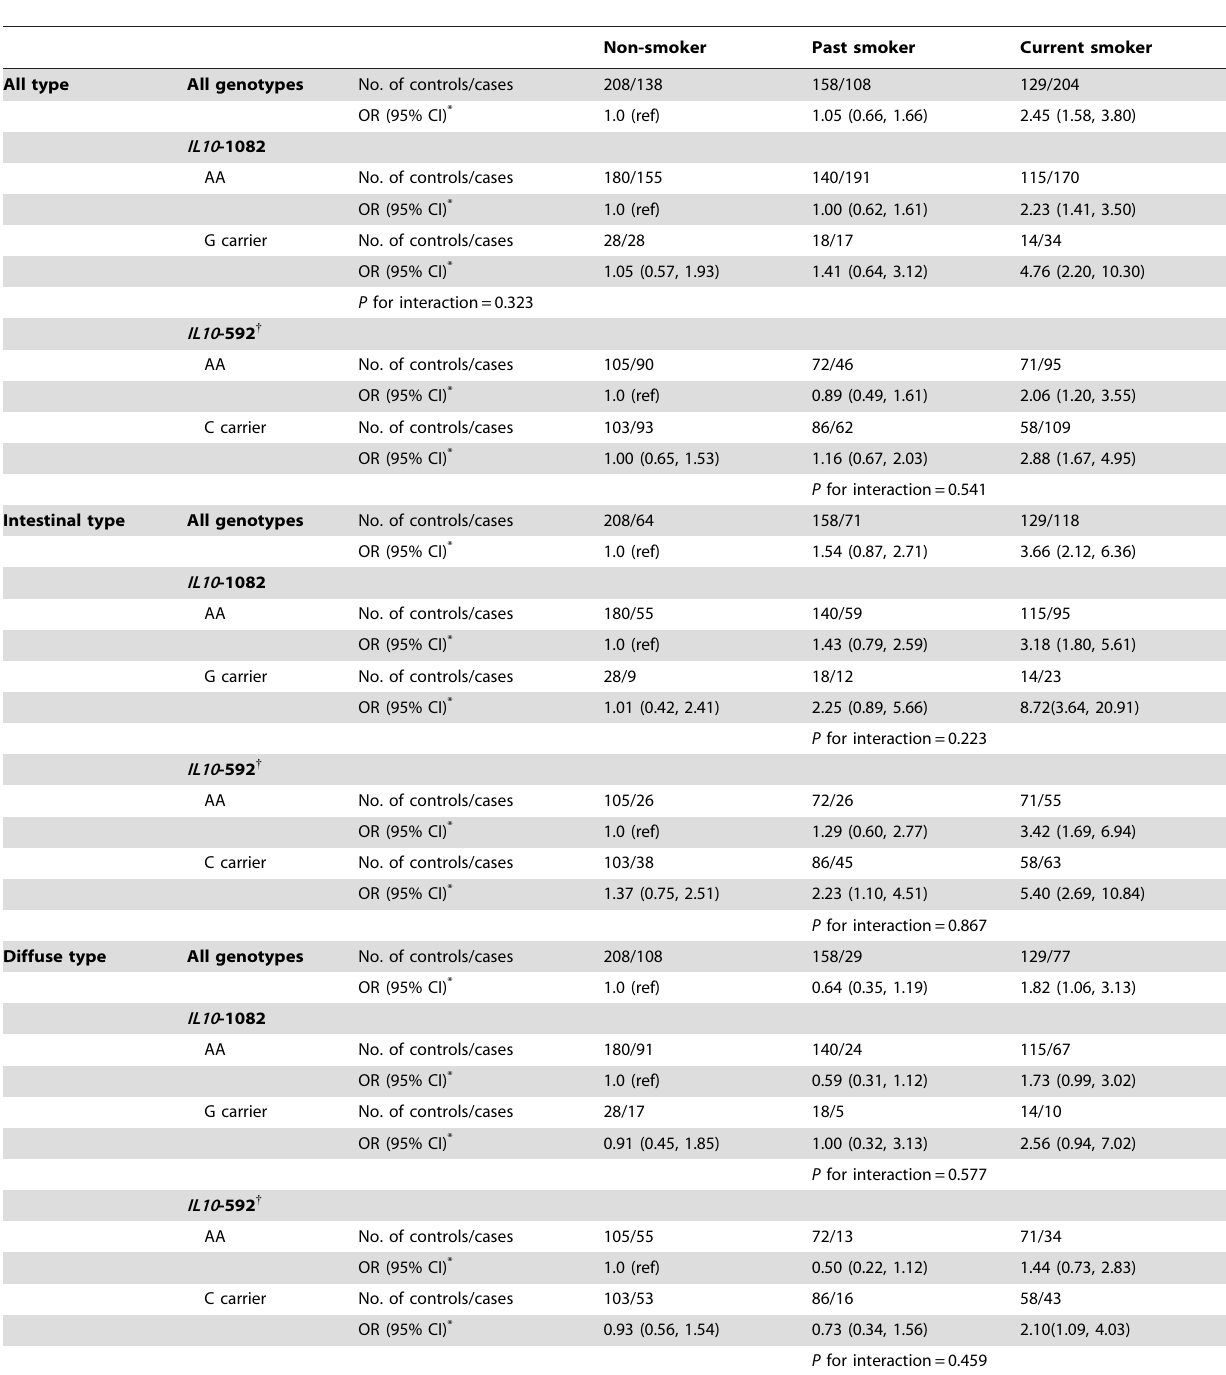
Table 4. The Effects of Smoking Status on the Association between IL10 Genetic Variants and the Risk of Noncardia Gastric Cancer, Stratified by Histological